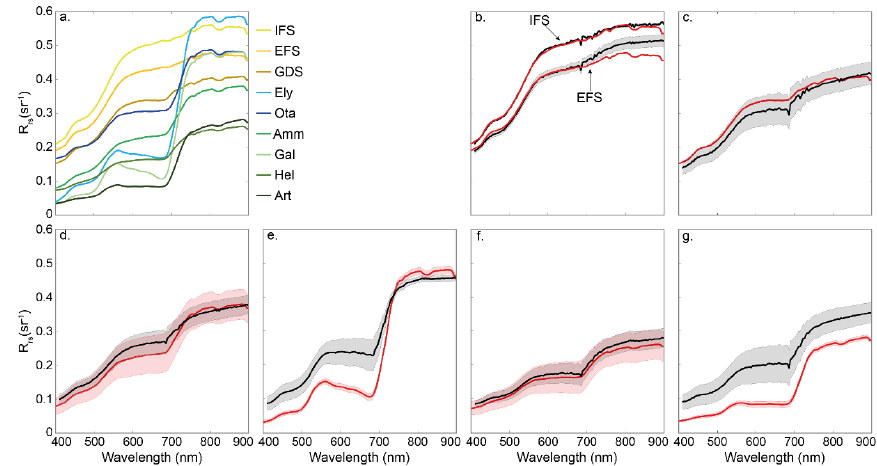
Figure 5. ( a ) Mean ground reference R rs spectra ( R G-REF ) and comparison with mean airborne reference R rs spectra ( R A-REF ) for ( b ) incipient foredune sands (IFS) and established foredune sands (EFS), which